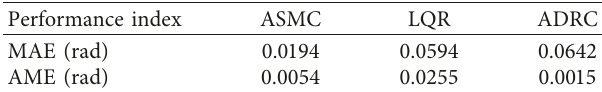
Table 6: Comparison of the pitch tracking performance under the wind speed of 2.8m/s.